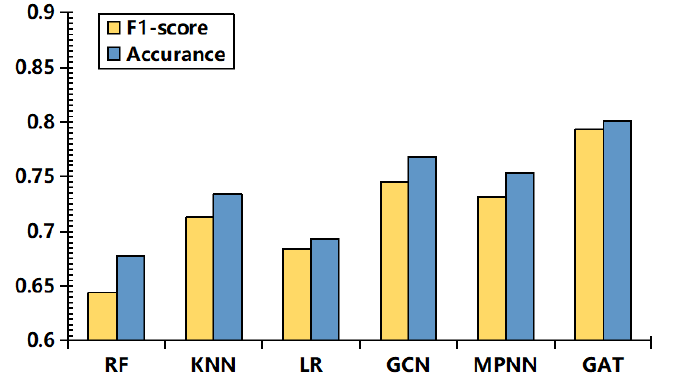
Figure 16. The experimental